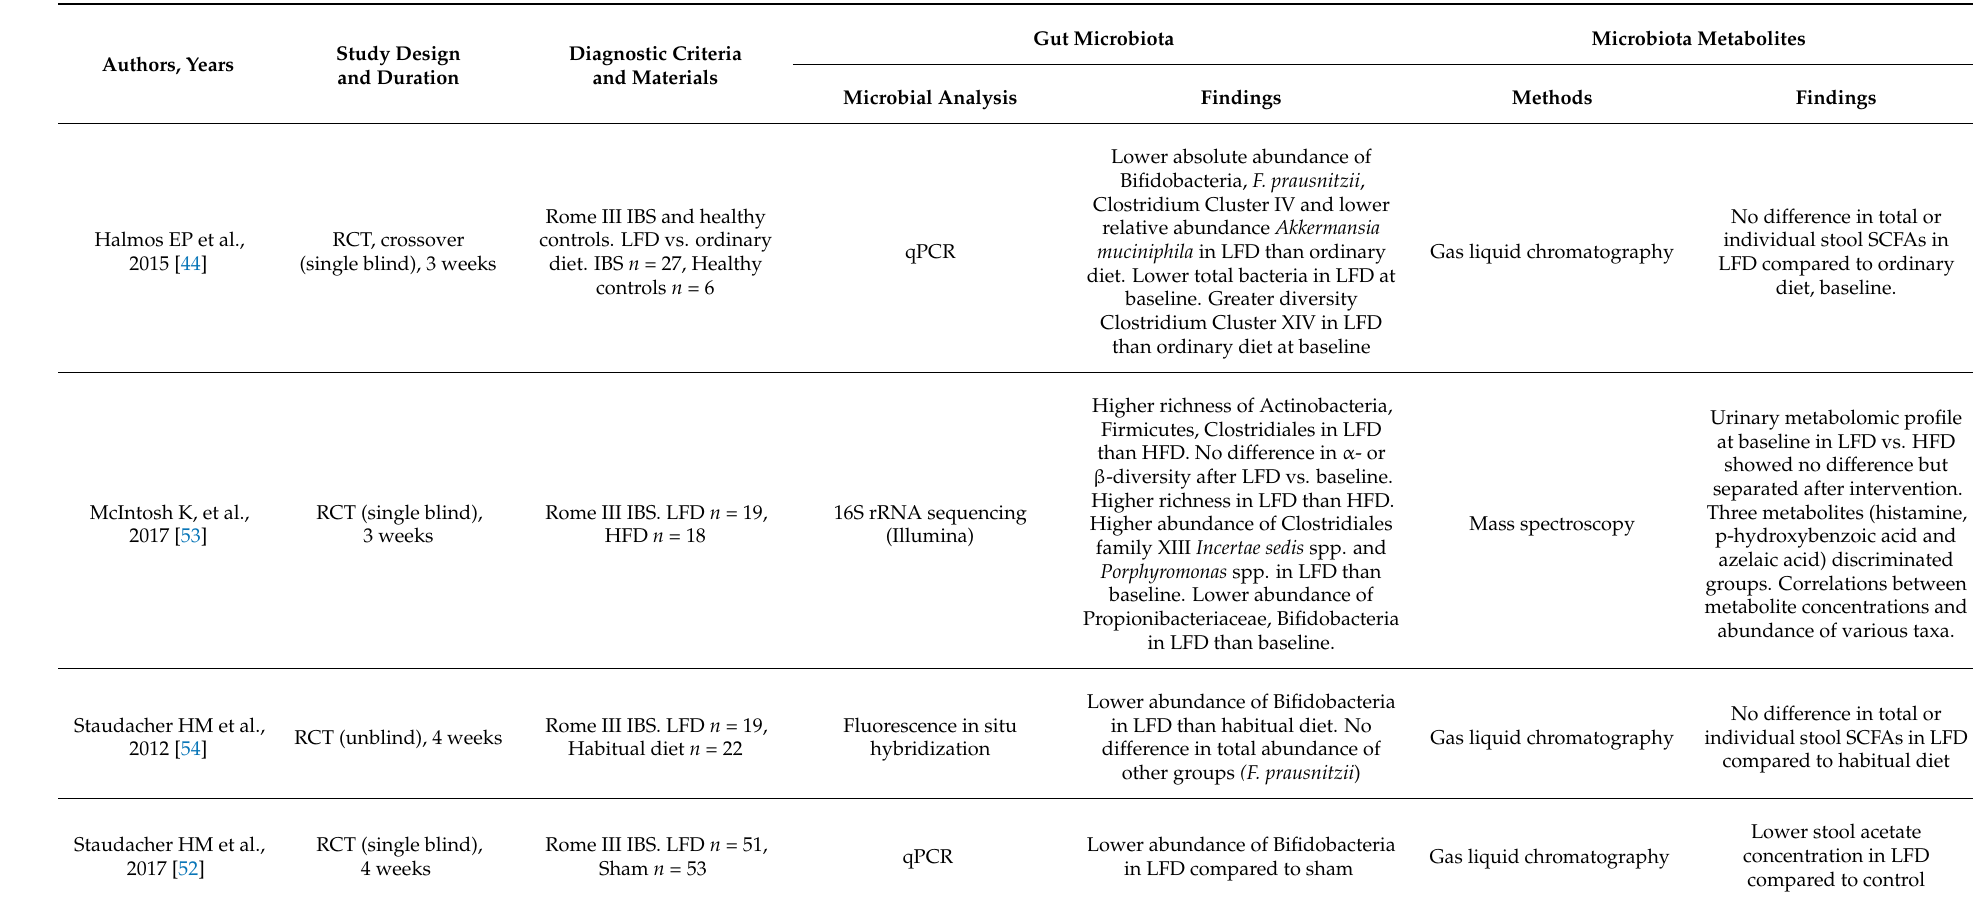
Table 2. Randomized controlled trials investigating the effect of low FODMAP diet on gut microbiota and microbiota